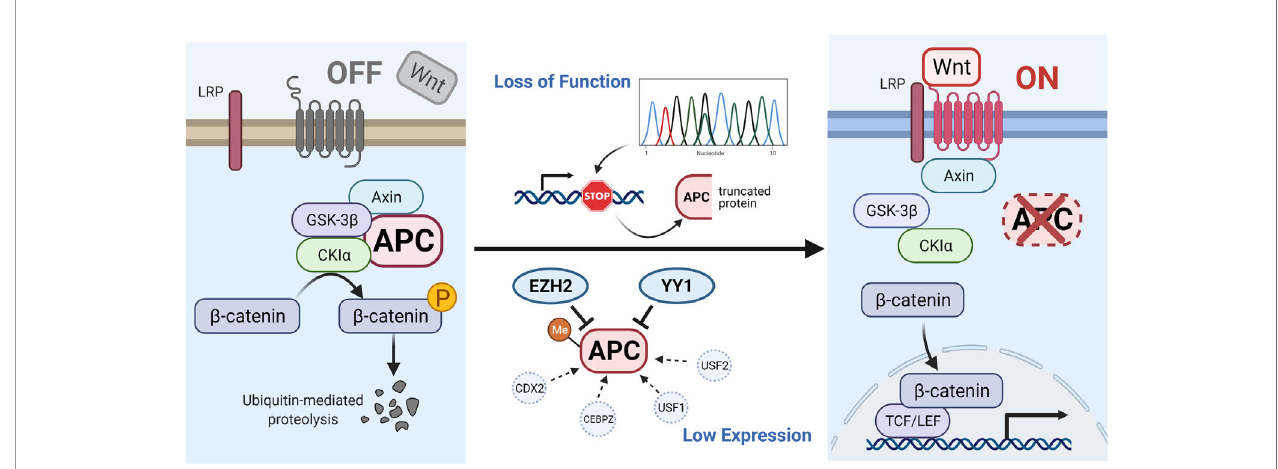
FIGURE 1 | Illustration of APC gene-related pathways and interactive genes. In the absence of a Wnt signal (Wnt/ b -catenin signaling pathway is inactive state, see left), the phosphorylated b -catenin can be formed by the destruction complex and degraded by ubiquitin-mediated proteolysis. Protein truncation generated by mutation in the APC gene or decreased level of APC protein in fl uenced by other factors (such as hypermethylated APC promoter, improved expression of EZH2 and YY1, or suppressed expression of CDX2, CEBPZ, and USF1/2) can activate the canonical pathway (Wnt signaling active, see right). When the destruction complex disassembles, the b -catenin fails to be degraded and accumulates in the cytoplasm, translocates into the nucleus, and binds to TCF/LEF transcription factor family, causing the abnormal expression of downstream genes. The illustration was created with BioRender.com.